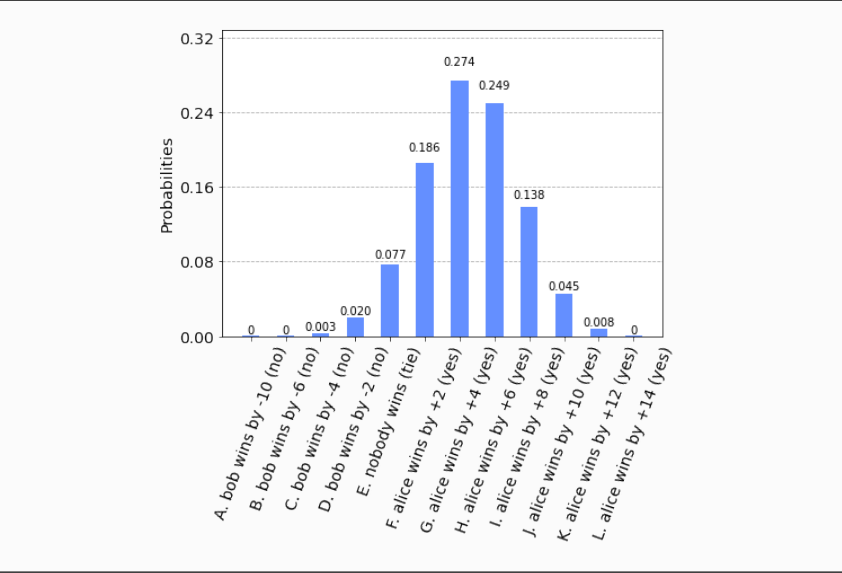
Figure 12. The possible outcomes and their probabilities when r A = 0.5 and r B = 1.